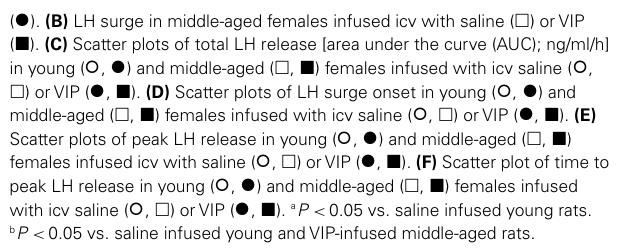
• ). (B) LH surge in middle-aged females infused icv with saline ( (cid:3) ) orVIP ( ( (cid:2) ). (C) Scatter plots of total LH release [area under the curve (AUC); ng/ml/h] ◦ • ◦ in young ( , ) and middle-aged ( (cid:3) , (cid:2) ) females infused with icv saline ( , • ◦ • (cid:3) ) orVIP ( , (cid:2) ). (D) Scatter plots of LH surge onset in young ( , ) and ◦ • middle-aged ( (cid:3) , (cid:2) ) females infused with icv saline ( , (cid:3) ) orVIP ( , (cid:2) ). (E) ◦ • Scatter plots of peak LH release in young ( , ) and middle-aged ( (cid:3) , (cid:2) ) ◦ • females infused icv with saline ( , (cid:3) ) orVIP ( , (cid:2) ). (F) Scatter plot of time to ◦ • peak LH release in young ( , ) and middle-aged ( (cid:3) , (cid:2) ) females infused ◦ • with icv saline ( , (cid:3) ) orVIP ( , (cid:2) ). a P < 0.05 vs. saline infused young rats. ◦ b P < 0.05 vs. saline infused young andVIP-infused middle-aged ) orVIP